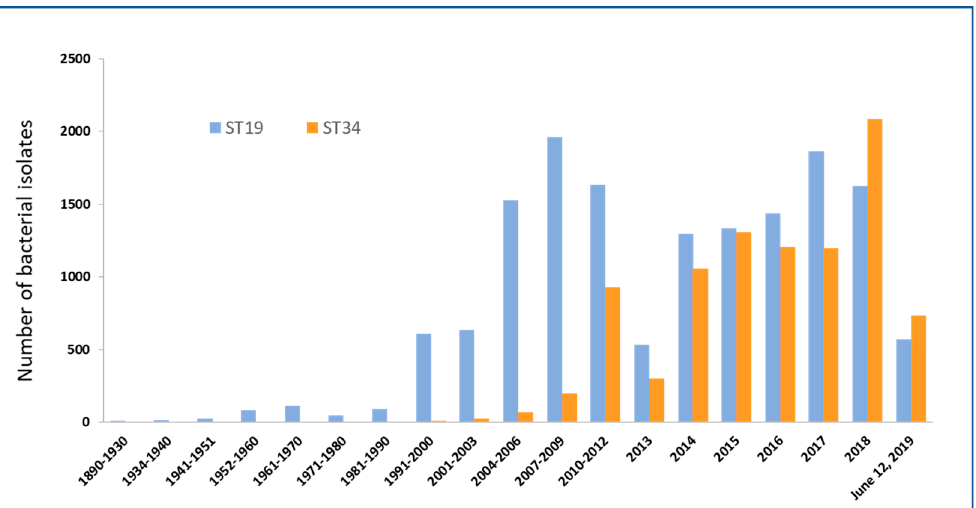
Figure 1. Emergence of global pandemic clone sequence type 34 (ST34) as compared to the “traditional” clone ST19 from 35,963 Salmonella Typhimurium isolates of the Enterobase [16]. Comparative analysis of number of isolates of ST19 and ST34 reported since 1890 till date shows that the increase in number of ST34 isolates in recent years.